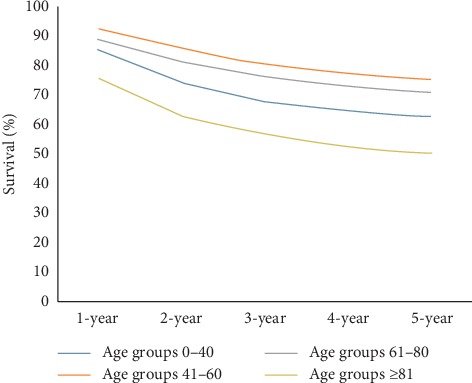
Trend analysis of cancer-free survival rates according to various age groups.